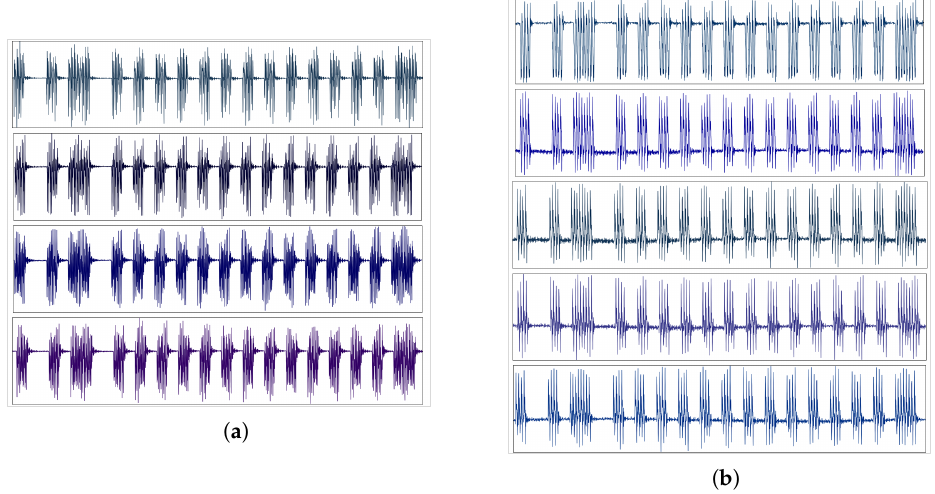
Figure 5. Example of randomly picked data samples of the 9 types. ( a ) The normal signals of NFC tags. ( b ) The first row for wireless-relayed signal, followed by four wire-relayed